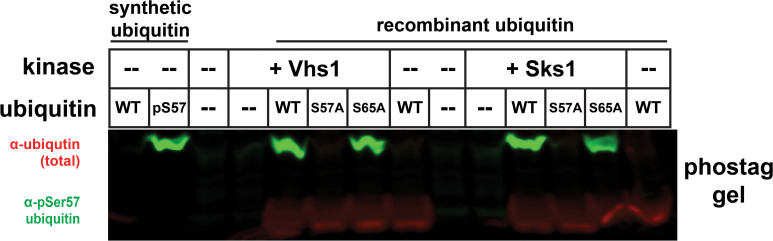
Phos-tag gel separation of ubiquitin (wildtype, S57A, or S65A variants) following co-expression with Vhs1 or Sks1.